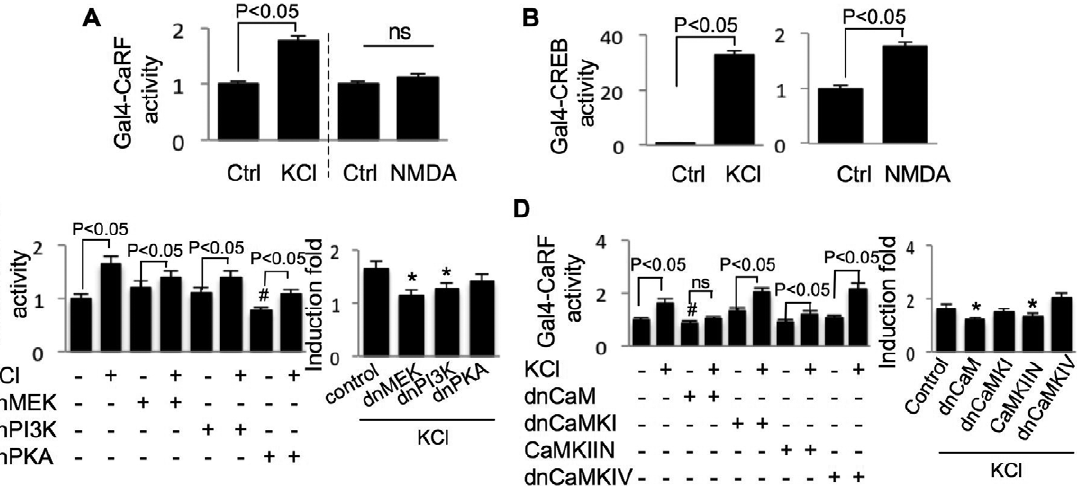
Figure 9. Regulation of CaRF-mediated transcription by Ca 2 + -stimulated protein kinases. Neurons on DIV 9 were transfected with Gal4 only, or Gal4-CaRF, or Gal4-CREB together with Gal4-UAS-Luc and TK-pRL. After 48 hours, the neurons were treated with 50 mM KCl (A) or 20 m M NMDA (B) for 6 hours, and examined by luciferase assay. Dominant negative MEK, PI3K, and PKA (C), or CaM, CaMKI, CaMKIV, and CaMKIIN (D) were co-transfected with the reporter constructs. The data was normalized to TK-Renilla luciferase activity, and then Gal4-CaRF or Gal4-CREB activity was normalized to neurons transfected with Gal4 only. ns: not statistically different. In the left panels of C and D, ‘‘ # ’’ indicates significant difference between neurons expressing dn construct and the naı¨ve neurons without dn construct. In the right panels of C and D, the effect of dn construct on KCl-stimulated transcription was normalized to the dn construct-only group (*: statistically different to that of KCl-stimulated transcription in neurons not expressing any dn construct). Data were collected from 12 independent preparations for each